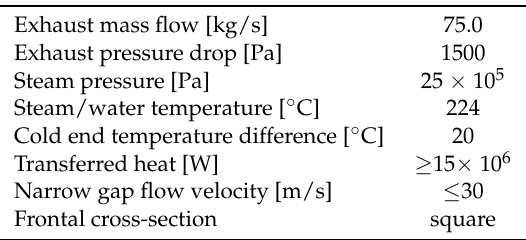
Table 3. Boiler section case study: Definitions and